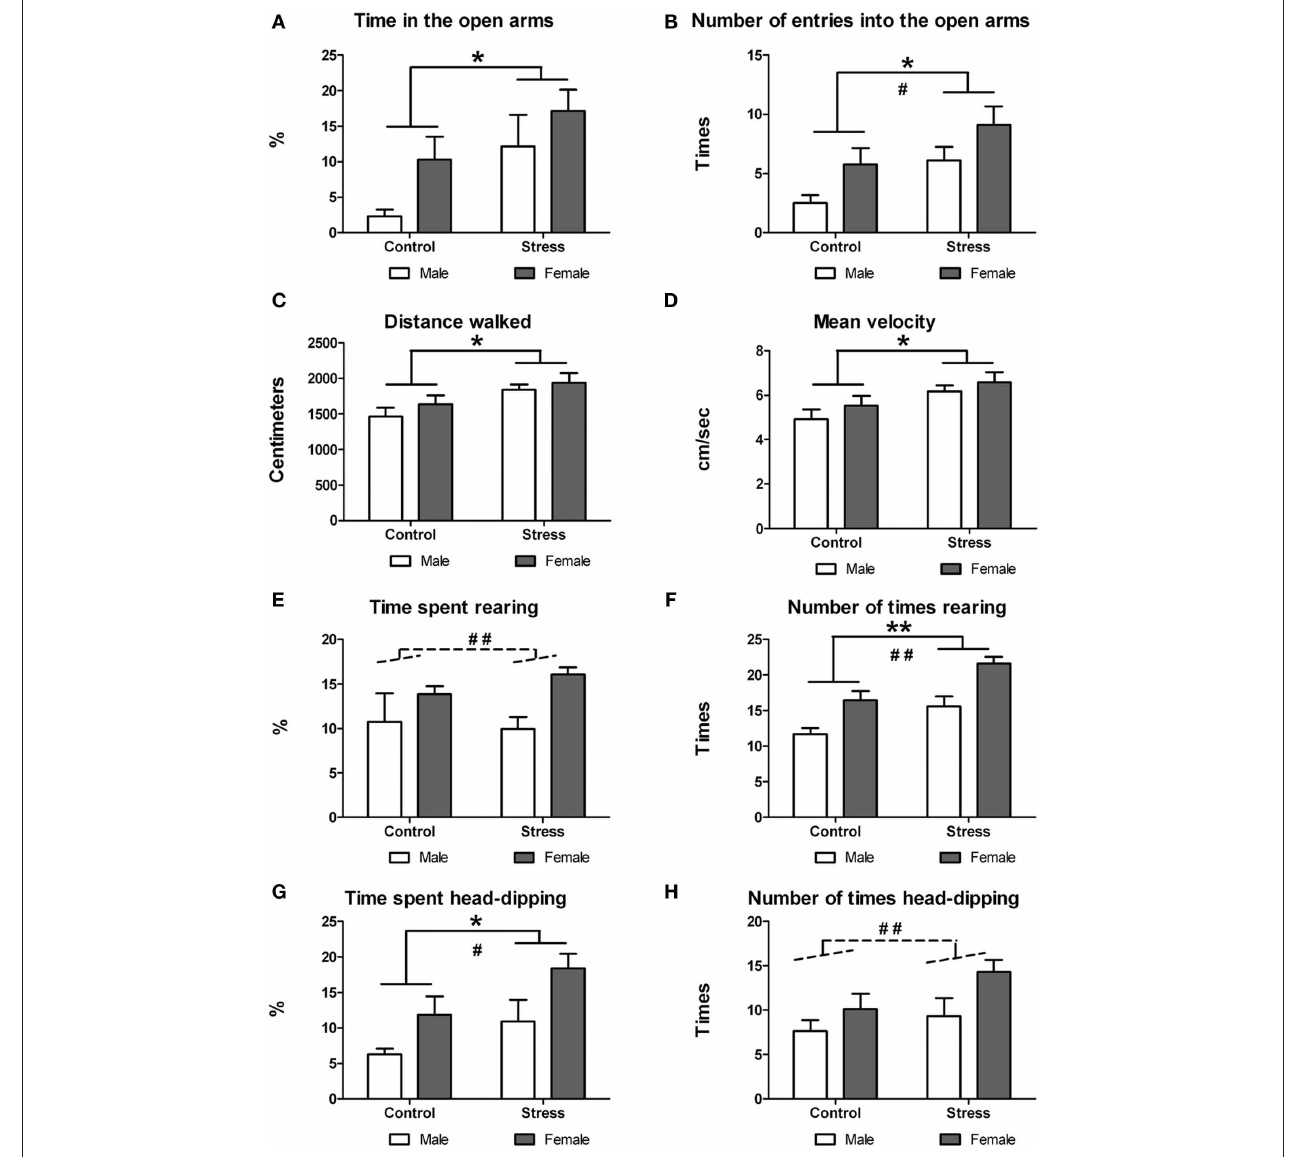
Figure 4 | effect of peri-pubertal stress on behavior at the elevated plus maze (epm) test. Mean (SEM) behavioral measures in the EPM test for male and female rats that underwent either peri-pubertal stress (Stress) or no stress (Control). (a) Time in the open arms, (B) number of entries into the open arms, (c) distance walked, (D) mean velocity, (e) time spent rearing, (F) number of times rearing, (g) time spent head-dipping, and (h) number of times head-dipping. * p < 0.05 treatment effect; ** p < 0.01 treatment effect, # p < 0.05 sex effect, ## p < 0.01 sex